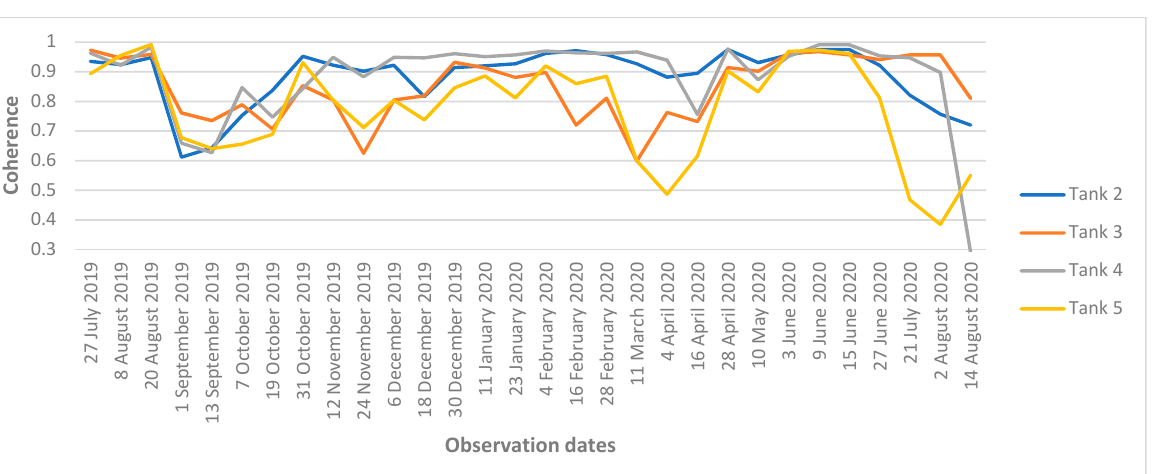
Figure 11. Interferometric phase for 12 day intervals in 2019–2020. In order to reveal the possible long-term and small-scale displacements of the tanks, the phases from Figure 11 were accumulated sequentially, and the plot of the accumulated phases since 27 July 2019 is presented in Figure 12. As can be seen here, the phase of all the tanks was close to zero during August 2019. The first sharp phase deviation from zero occurred on 13 September. In the adopted scheme of interferometric processing, such a phase increment could be misinterpreted as the subsidence of the scattering surface if ig- noring the fact of the regular phase deviation of the signal propagating through the snow layer. Further, throughout the winter, an increase in tank 5’s phase can be seen. It grows (represented by the yellow line) until the start of the snow melting period in April, then it drops to almost the zero level after the end of the snow melting period in May. Such phase variations could be interpreted as monotonous subsidence of tank 5 during the winter with a return to its original position in spring, if not taking into account the influence of snow. As for another tank, the phase of tank 4 decreases until the − 2 radian, as if there was